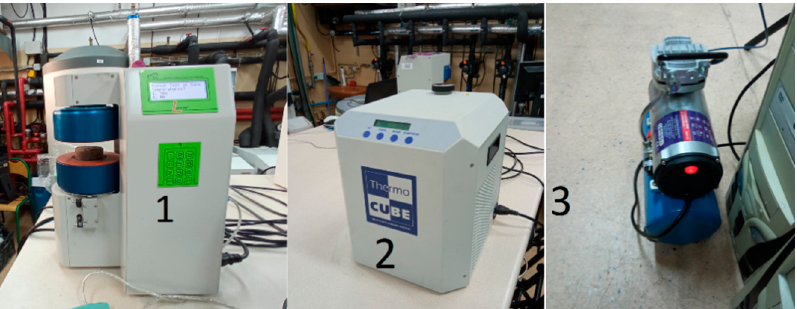
Figure 4. FOX 50 aperture with instrumentation. (1) Lambdameter FOX 50; (2) ThermoCube 200–500 Solid State Cooling System cooler; (3) compressor DED7472 Derda (photo by K. Se ń czuk).